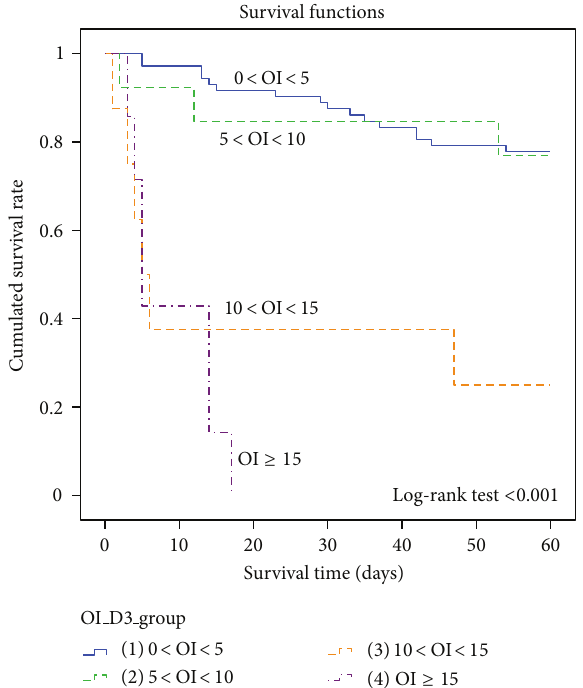
Figure 2: Kaplain Meier curve of stratified day 3 OI groups versus survival